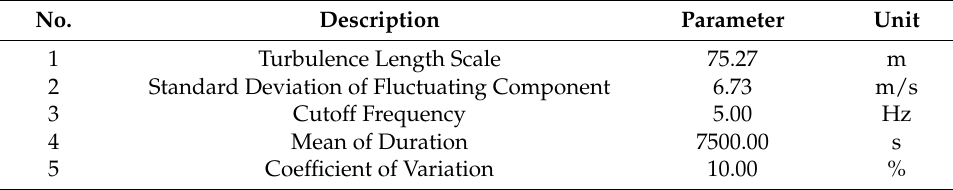
Figure 13. Flowchart for generating wind loads time history. Table 6. Corresponding parameters of long-duration wind loads.